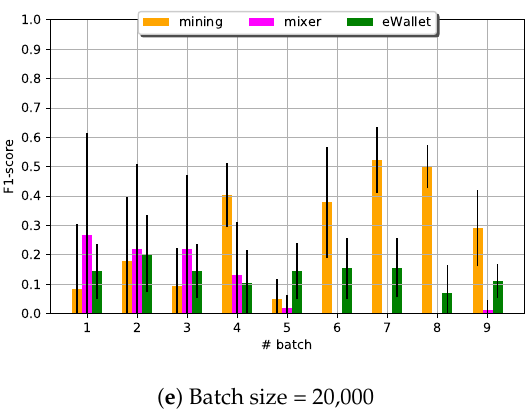
Figure 6. F1-score computed in the four presented experiments with different batch_size for Mining Pool, Mixer, and eWallet